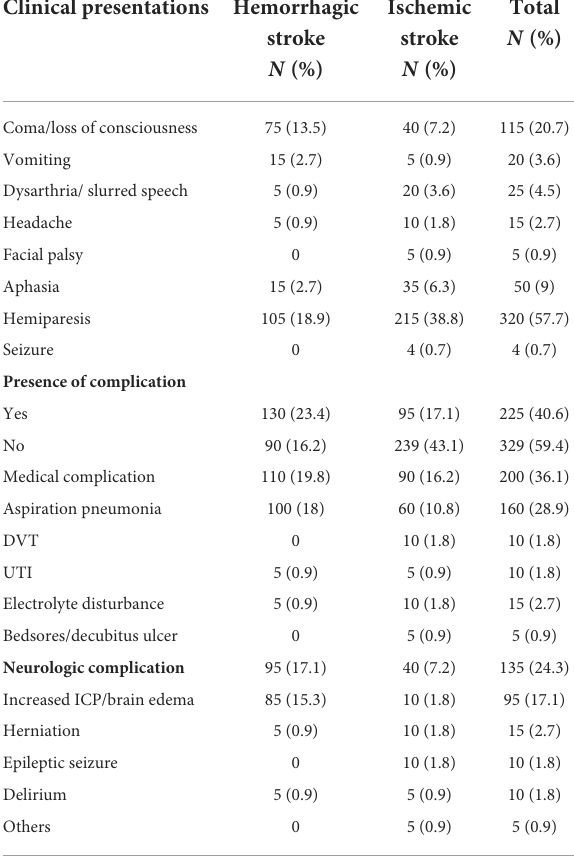
TABLE 2 Clinical presentation of patients with stroke admitted to public referral public hospitals, Northwest Ethiopia, 2020–2021. Clinical presentations